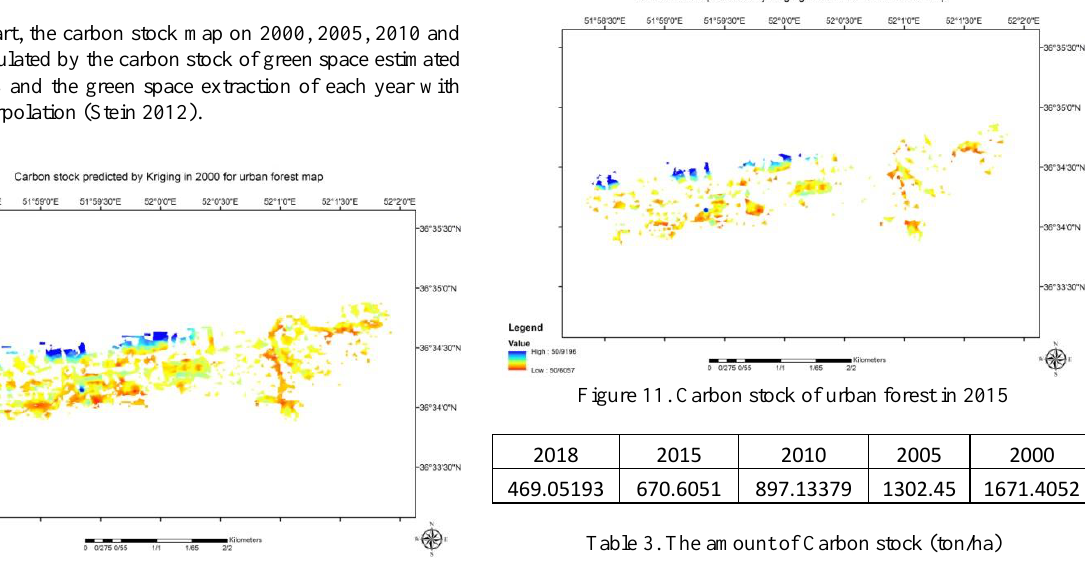
Figure 8. Carbon stock of urban forest in 2000